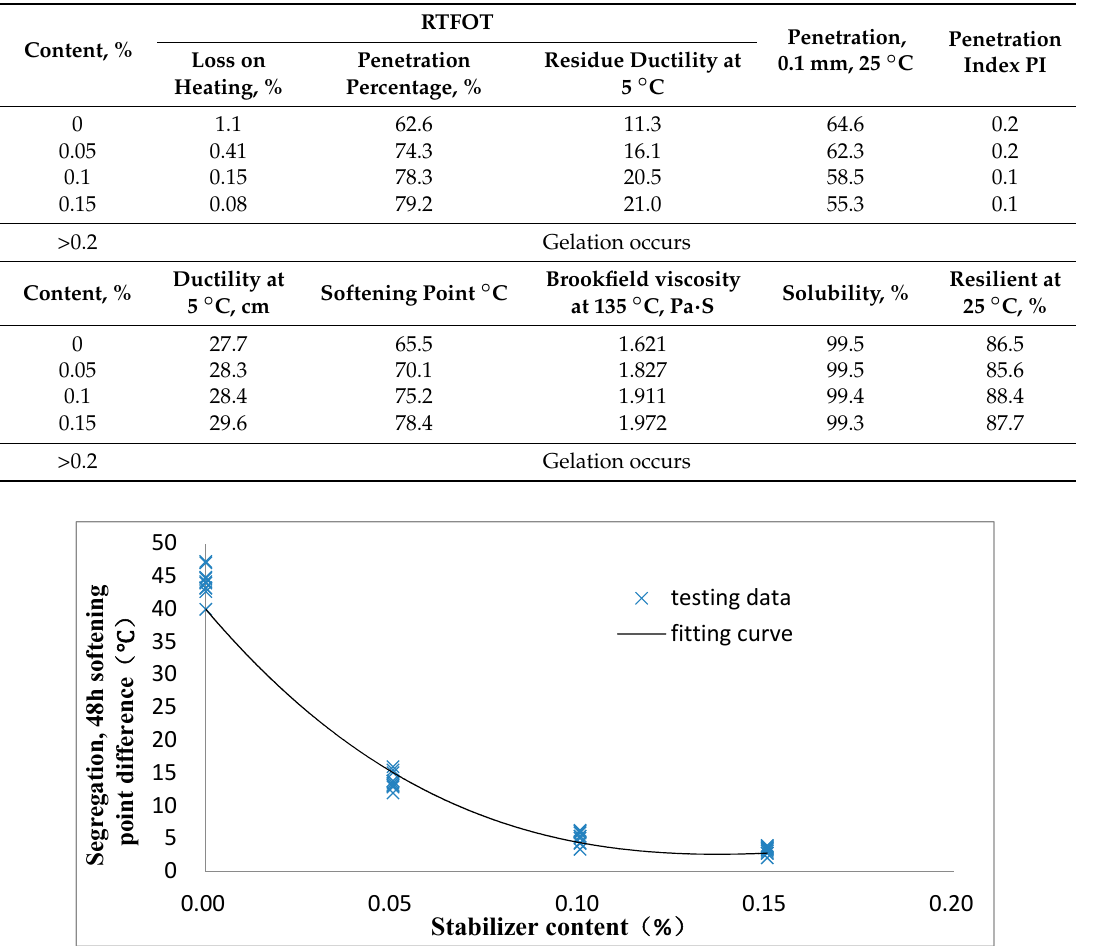
Table 5. The performance of modified bitumen with different stabilizer content.